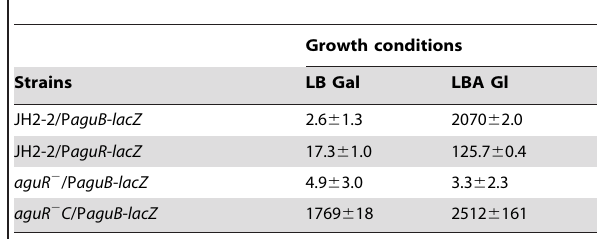
Table 3. b -galactosidase activity (MU) of strains carrying P aguB - or P aguR - lacZ fusions grown in the presence or absence of agmatine.